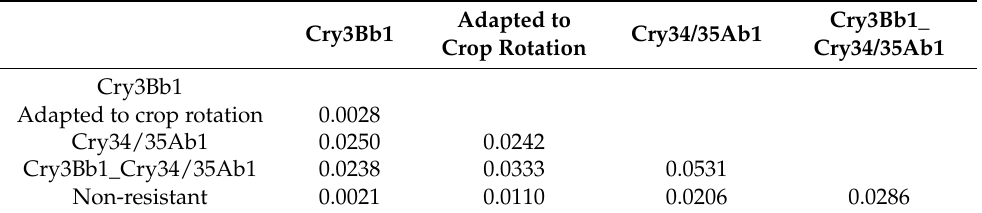
Table 3. Population pairwise estimates of fixation index (F ST ) .